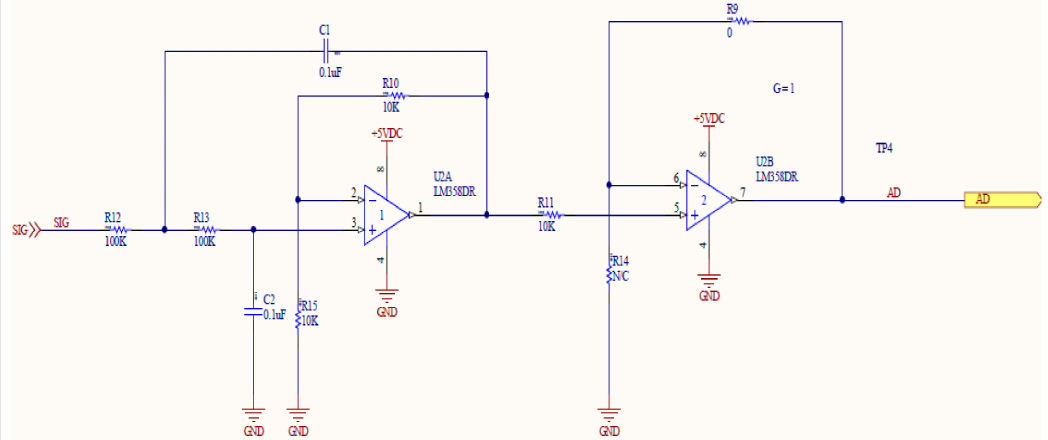
Figure 3. Signal-processing filter for